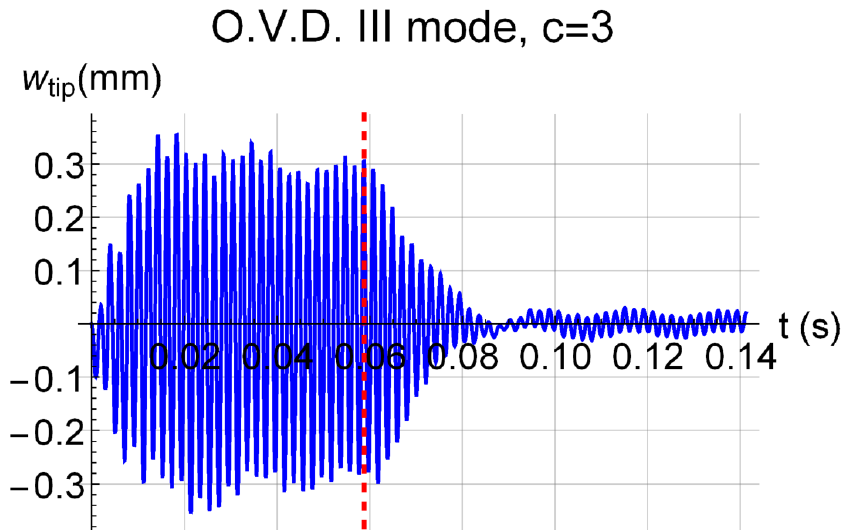
Figure 15. Example of damping efficacy of the O.V.D. when the second eigenmode was excited by a harmonic moment (amplitude = 1.2 Nm) concentrated at the tip. The dashed red line shows the instant of O.V.D. activation.